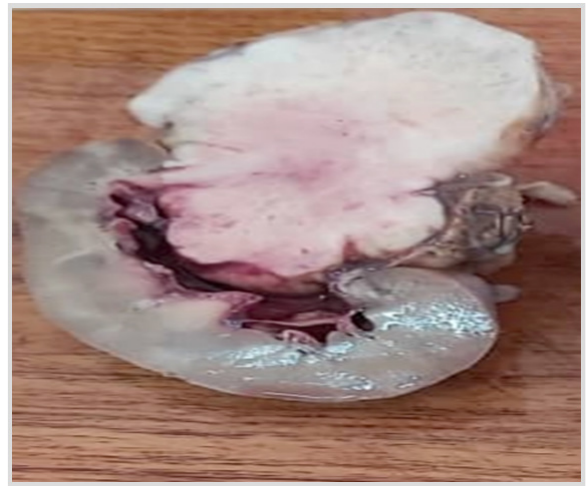
Figure 2: Macroscopic appearance of the sample after opening.